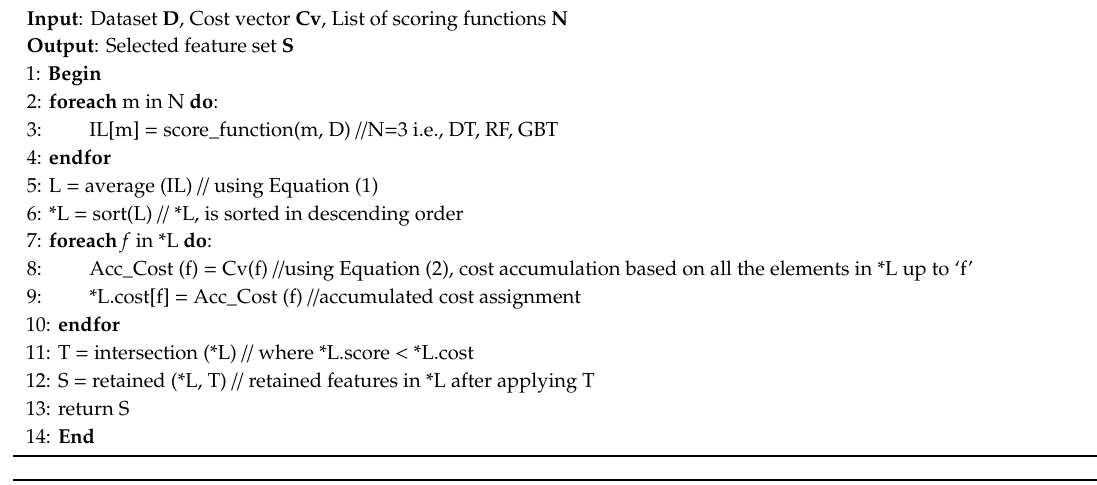
Algorithm 2 Ensemble-2